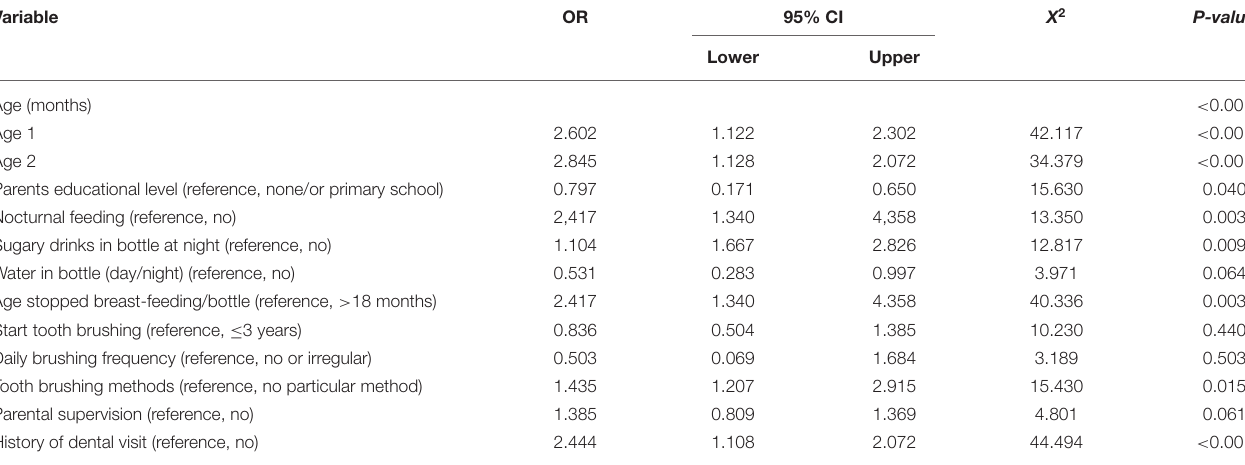
TABLE 4 | Factors associated with ECC in multiple logistic regression analysis. Variable